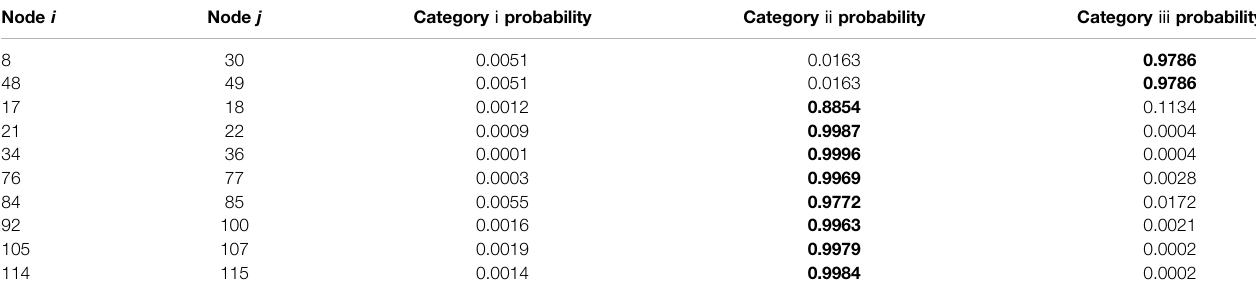
TABLE 2 | Probability distribution of the presence of con fl icting information and disconnected lines in various classi fi cations. Node i Node j